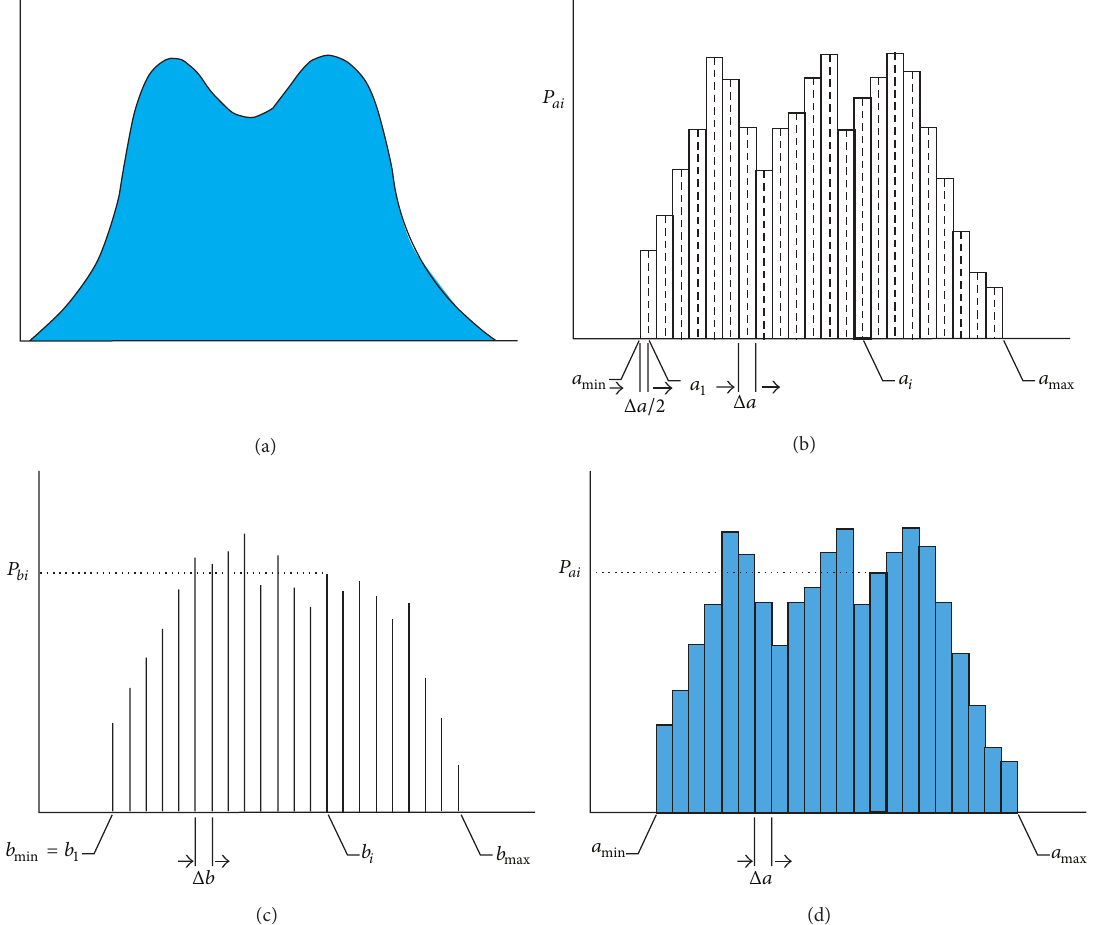
Figure 1: Approximation of the restricted probability distributions: (a) original approximation, (b) discrete approximation, (c) pure discrete approximation, and (d) piecewise uniform